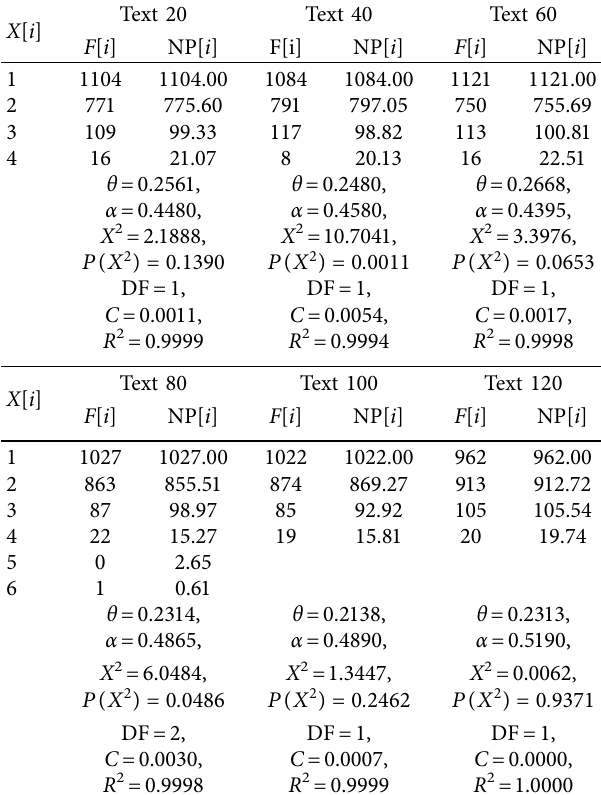
Table 1: Fitting of extended logarithmic to word-length distri- bution in six sample